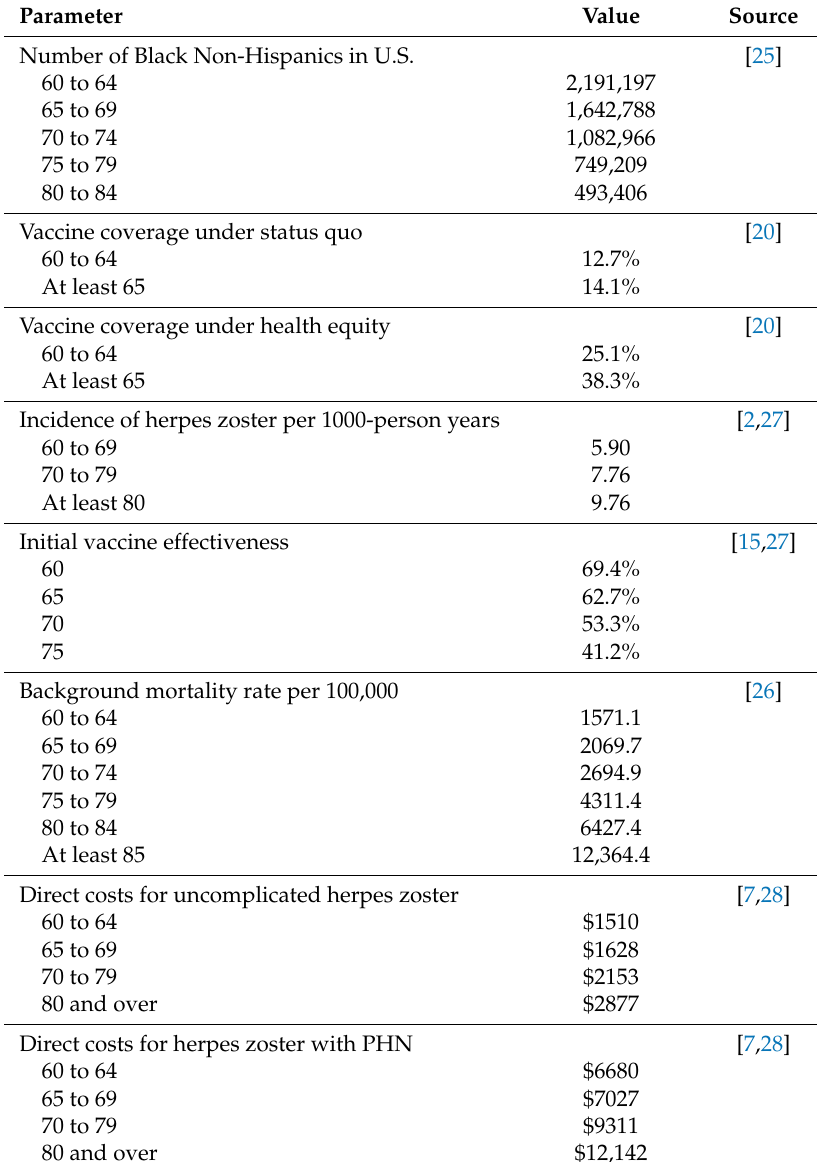
Table 1. Epidemiological and cost inputs for decision analysis